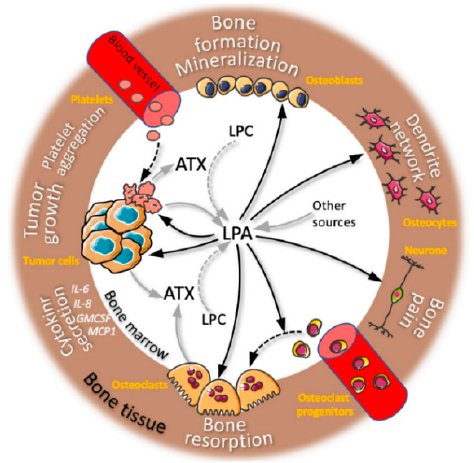
Figure 1. LPA activity in the microenvironment of bone metastasis: an overview of lysophosphatidic acid (LPA) activities on bone cells, cancer cells, and neurons. LPA activity on several cell types from the bone microenvironment (names in orange) results in multiple biological functions (black arrows) (text in white). Cell secretion of LPA or autotaxin (ATX) is indicated by grey arrows. Cell differentiation and platelet aggregation are indicated by dotted black arrows. ATX catabolism of LPC is indicated by dotted grey arrows. LPC: lysophosphatidylcholine [35]. Reprinted from an open access